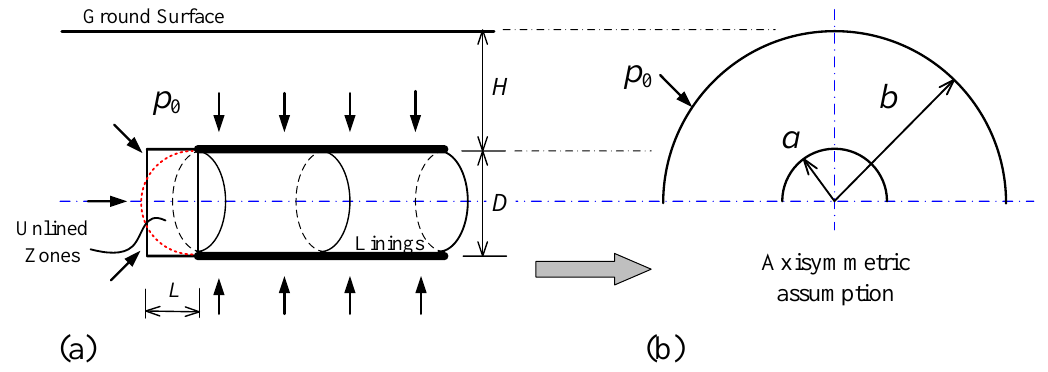
Figure 1. Schematic of a tunnel heading and the cavity contraction model: ( a ) schematic of a tunnel heading; ( b ) the cavity contraction model.